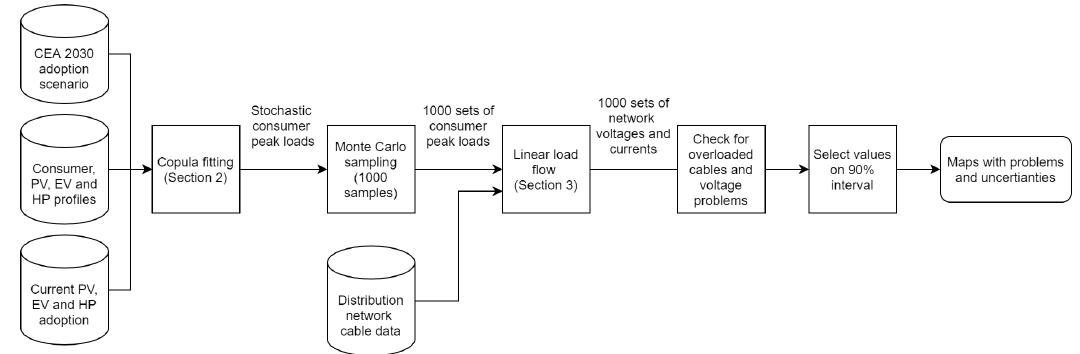
Figure 16. Diagram giving an overview of the steps performed in the case